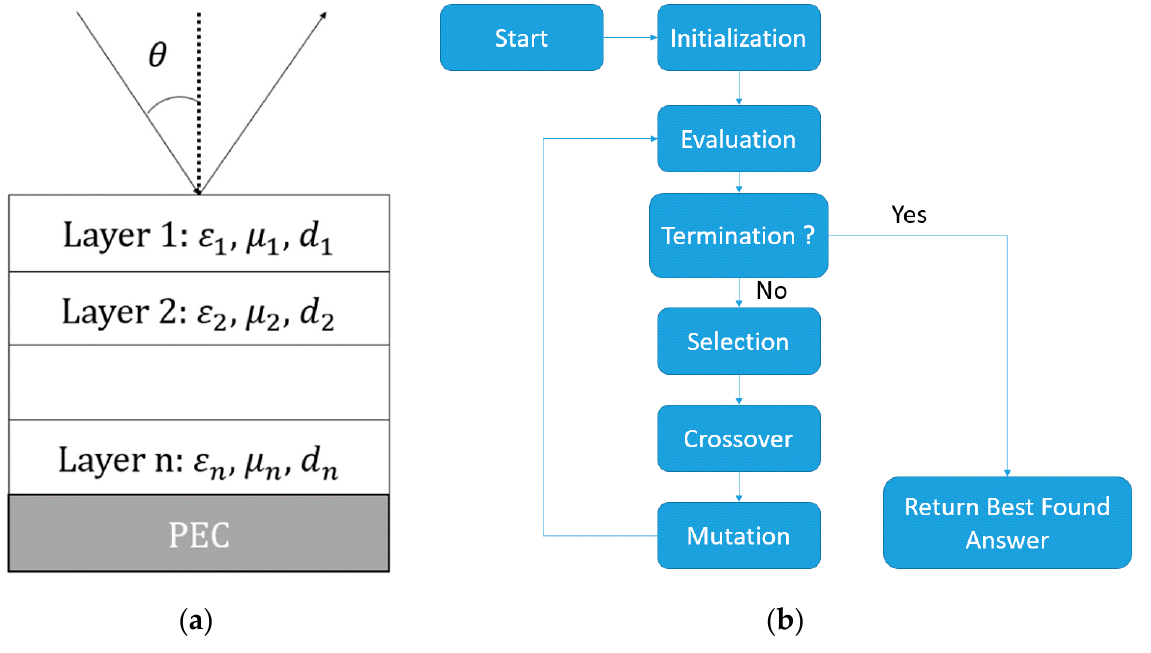
Figure 5. ( a ) Multilayer absorber structure; ( b ) flowchart of the GA optimization.